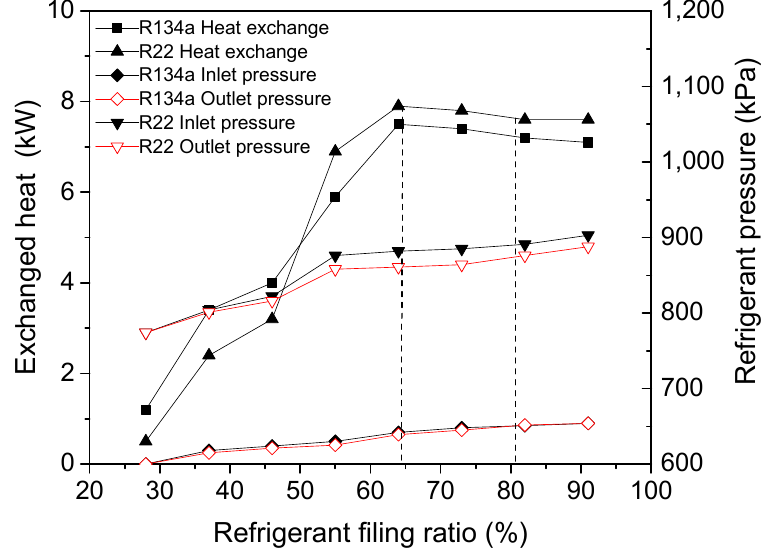
Figure 8. Heat exchange and refrigerant inlet and outlet pressure in evaporator.